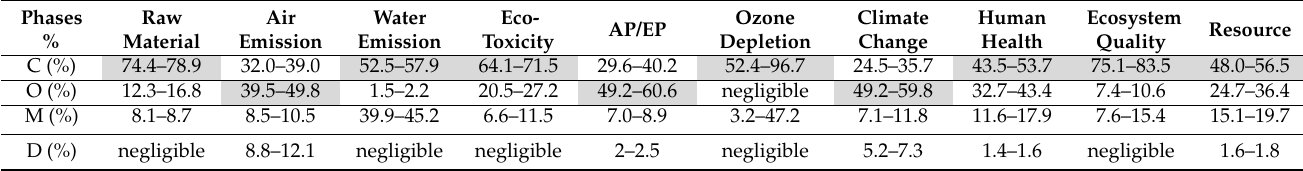
Table 9. Percent contribution in each life cycle for different impact